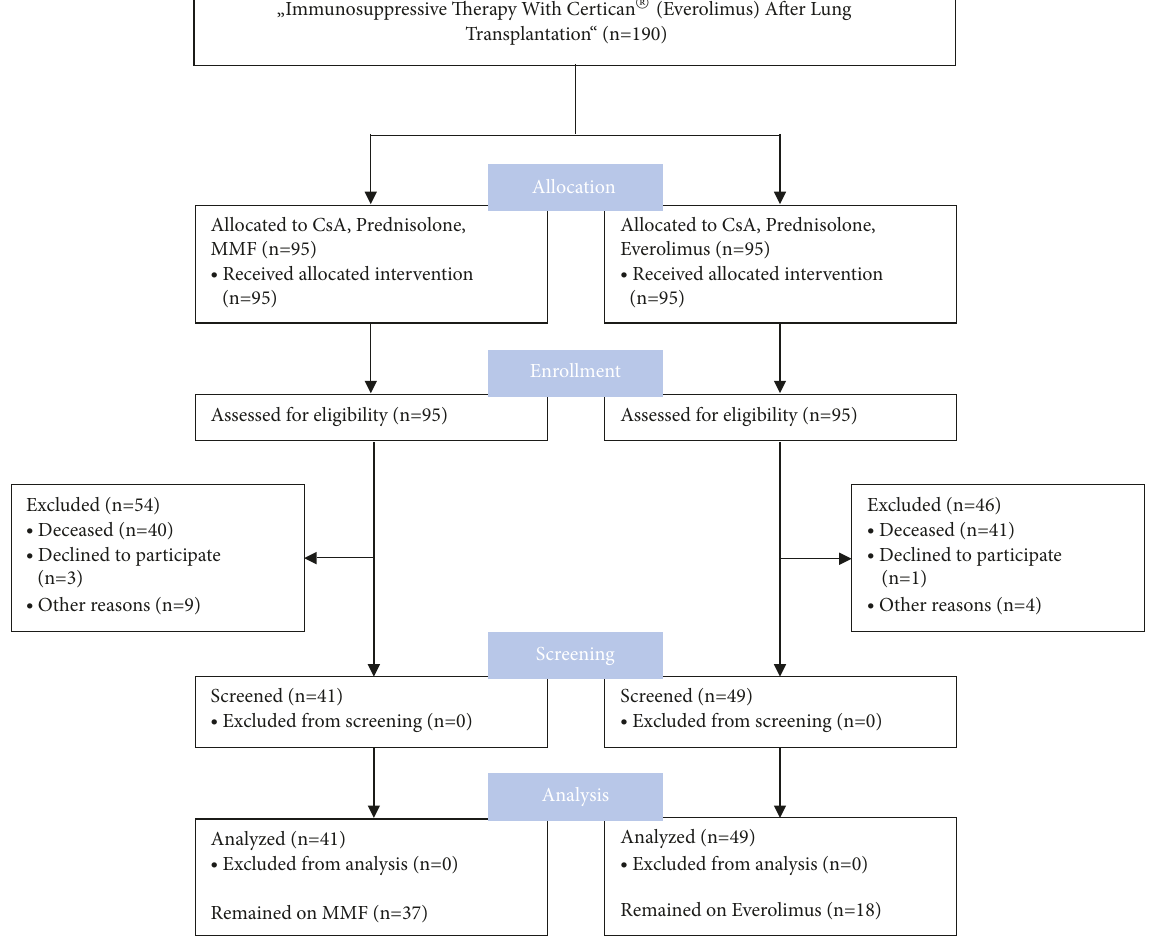
Figure 1: Adapted CONSORT 2010 Flow Diagram. Distribution of all potential and definite participants at each stage of the study. CsA, cyclosporine A; MMF, mycophenolate